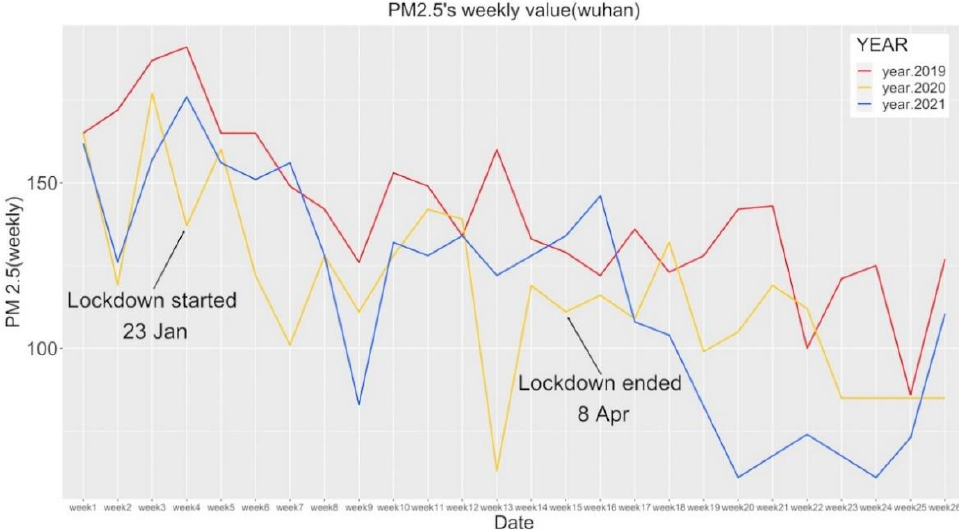
Figure 1. Weekly PM2.5 value (Wuhan).